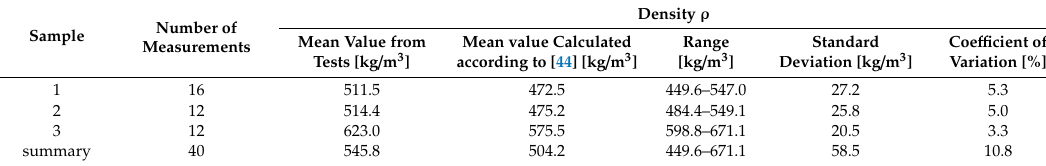
Table 5. Determined densities.